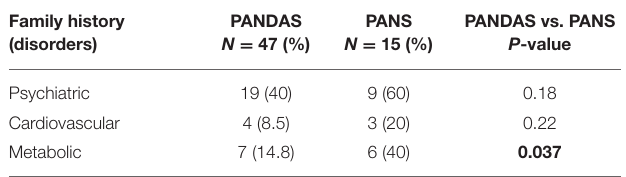
TABLE 2 | Clinical and epidemiological features.